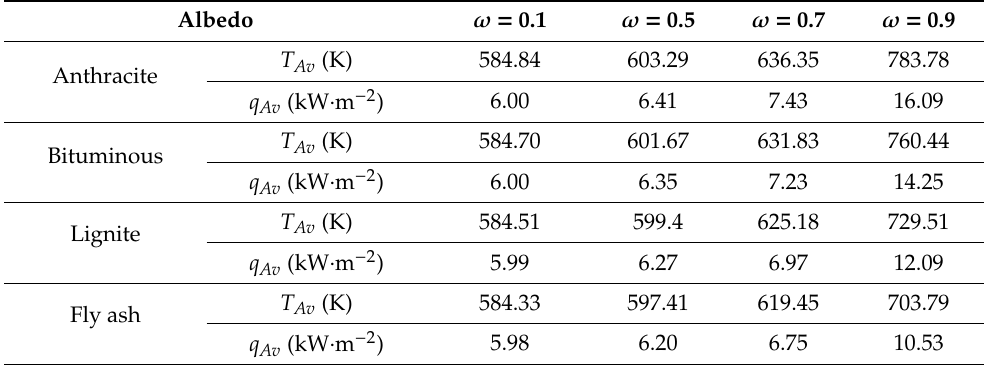
Table 5. The average temperature and net radiation heat flux density value for di ff erent albedo values ( κ = 1 m − 1 ).